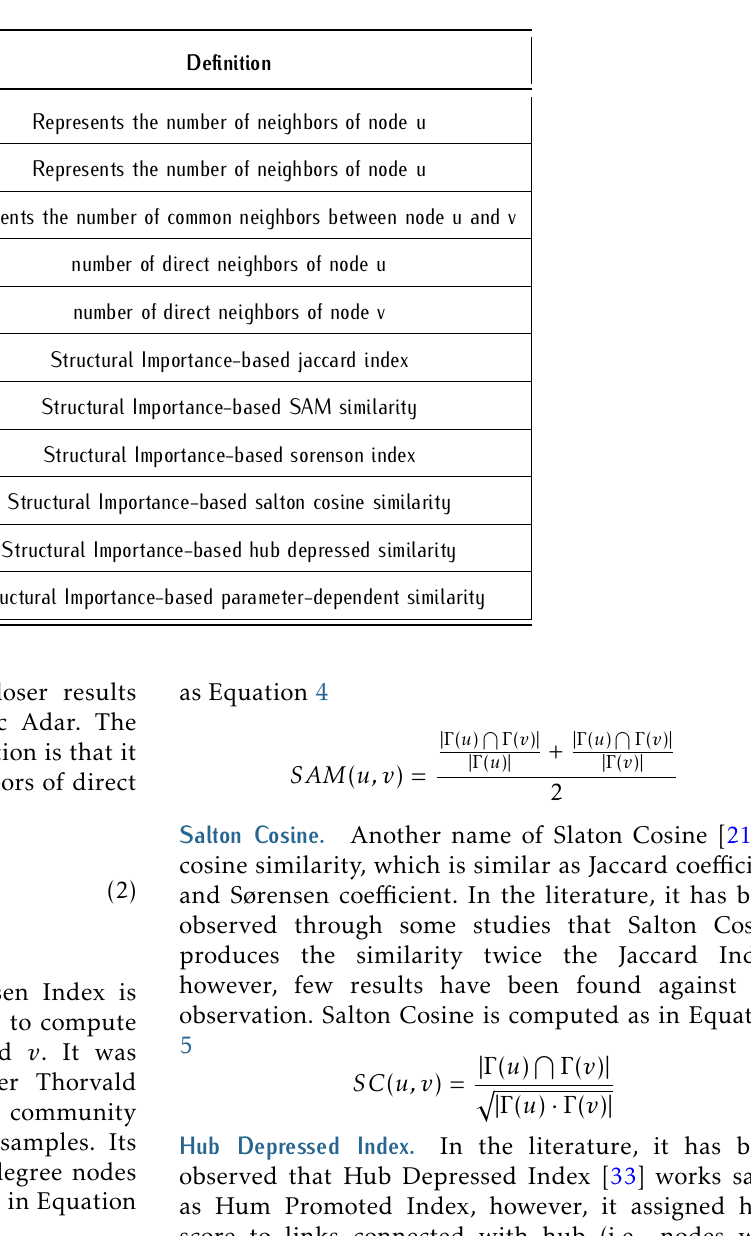
Table 2. Symbols and notations used in this